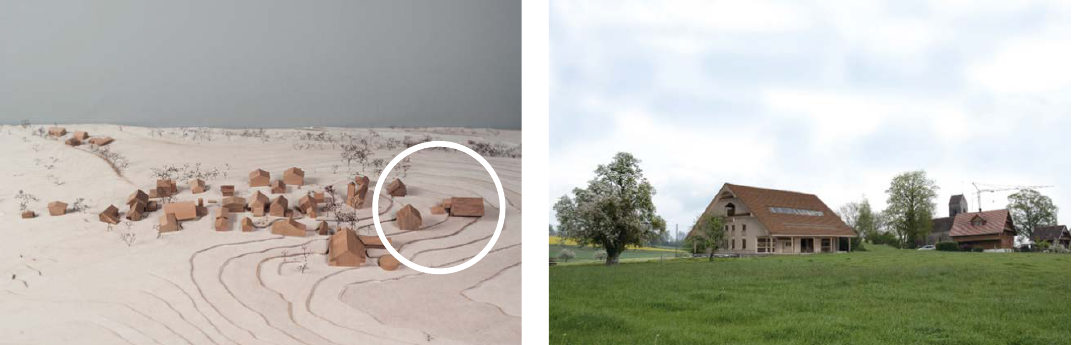
Figure 8. Development proposal for an old barn Figure 9. Development proposal for an old